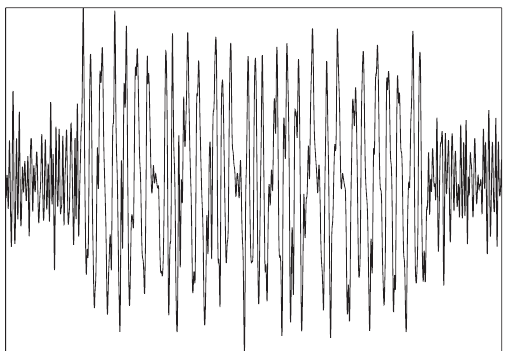
Figure 5: Derivative of a signal corrupted by speckle noise obtained by scanning the bar code in Figure